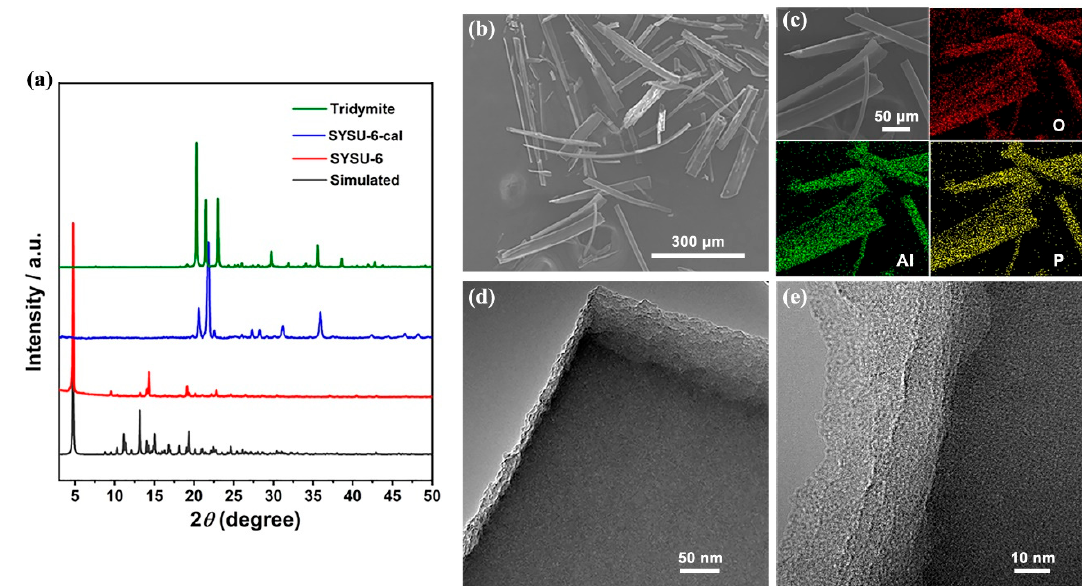
Figure 1. ( a ) Powder X-ray diffraction of Sun Yat-sen University No. 6 (SYSU-6) and SYSU-6-cal; ( b ) scanning electron microscopy (SEM) image of SYSU-6. Indication of the phase purity of SYSU-6; ( c ) SEM and corresponding mapping images for O, P, and Al elements; ( d , e ) transmission electron microscopy (TEM) images of SYSU-6.